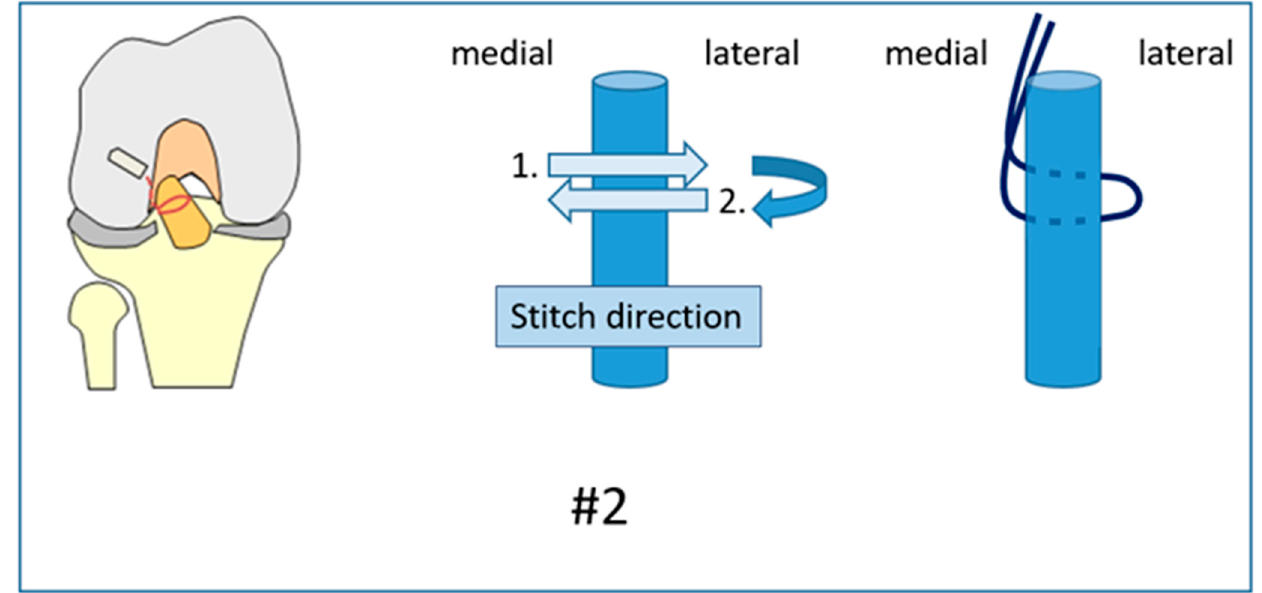
Figure 2. Suture #2 was the same stitch but returning at an angle of 180°, passing twice through the ACL.